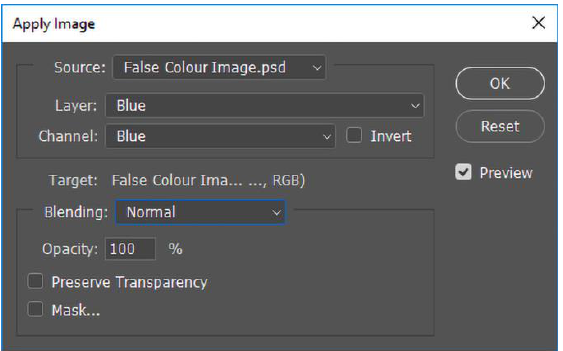
F IGURE 7: The “Apply Image” dialogue in Photoshop. The layer with the blue image gets overwritten with its own blue colour channel. The not needed green and red channels get